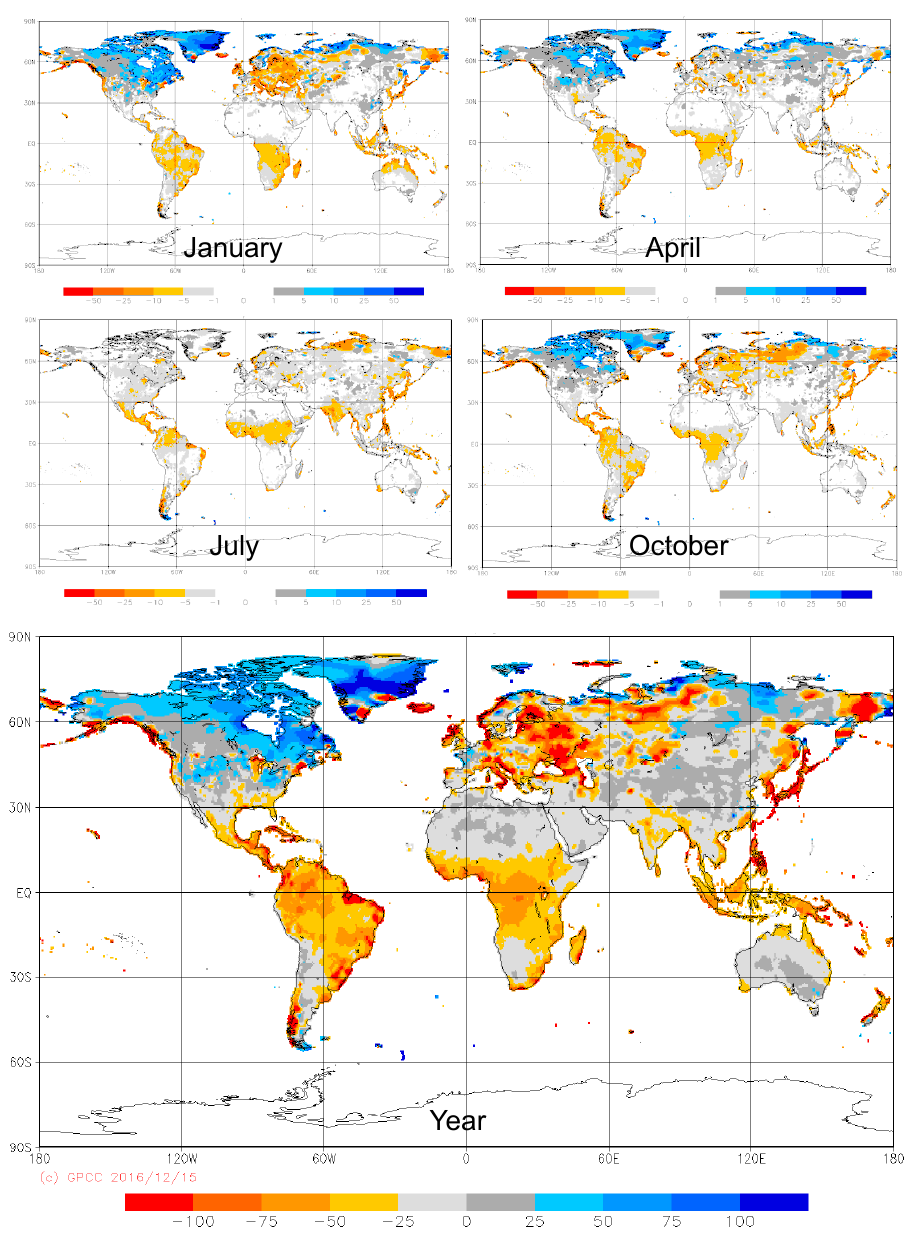
Fig. 9 Figure 9. Absolute differences (mm) between correction terms for the systematic gauge-measuring error according to GPCC and L&W1990 for January, April, July, October and the